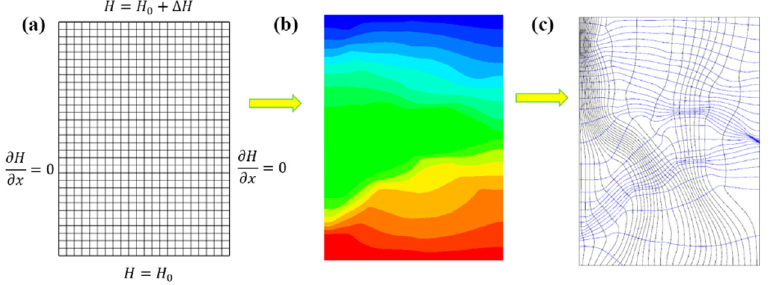
Figure 8. ( a ) Source calculation grid; ( b ) calculated pressure field; ( c ) streamlines and orthogonal time of flight iso-surfaces.